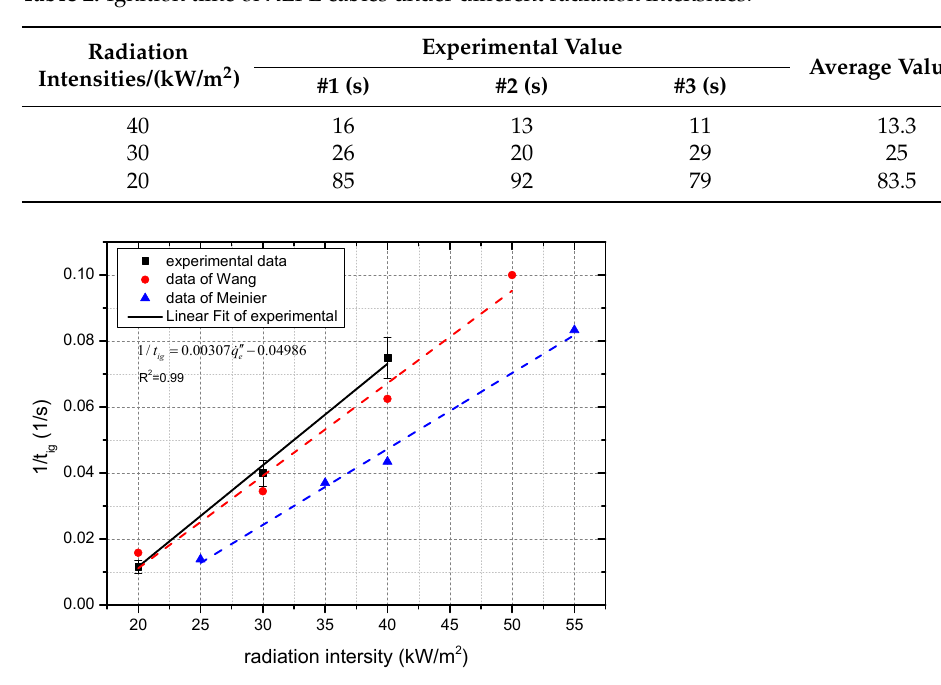
Table 2. Ignition time of XLPE cables under different radiation intensities.